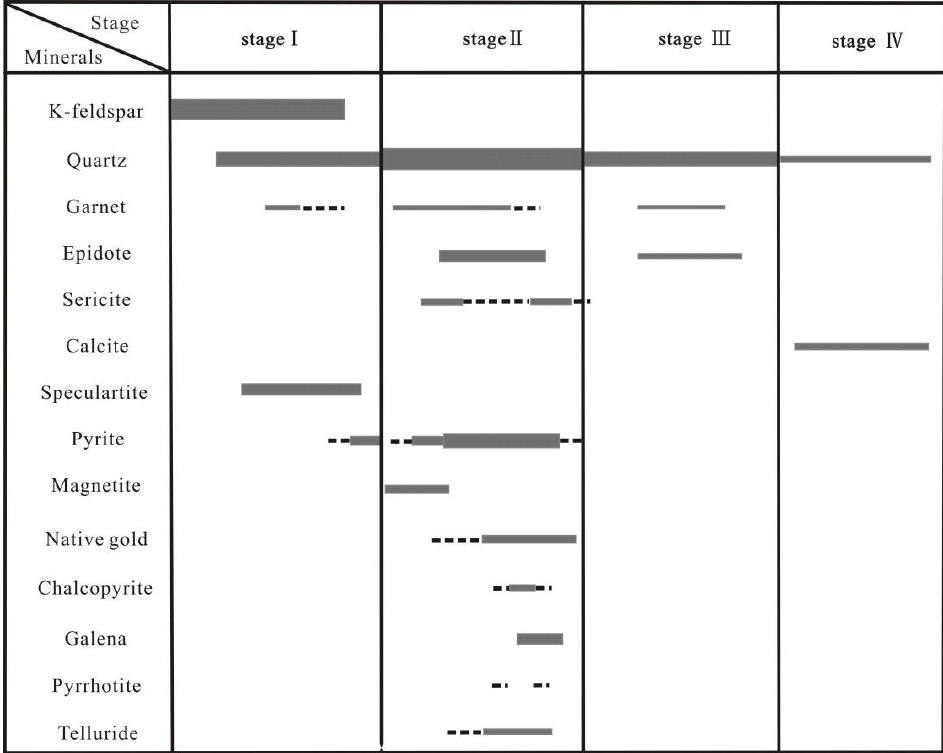
Figure 4. Paragenetic sequence for the Dongping deposit.